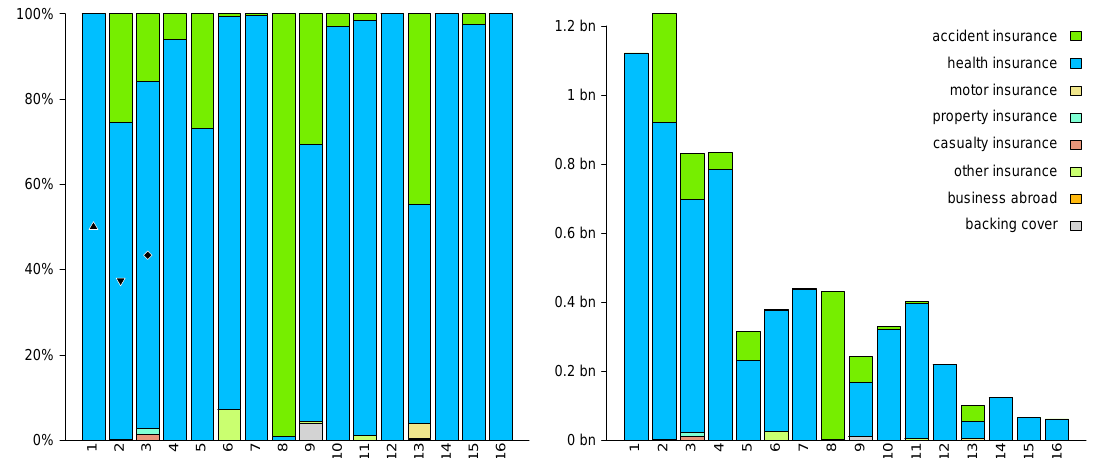
Figure A4. Health insurers’ assets ( top ), liabilities ( middle ) and insurance provisions ( bottom ) as used for the case study. Values on (lhs) are relative and in percentage, values on (rhs) are absolute and in billion CHF. For each line of business we indicate by (cid:78) , (cid:7) , (cid:72) the market shares based on earned premiums of the first, second and third largest insurer, respectively.